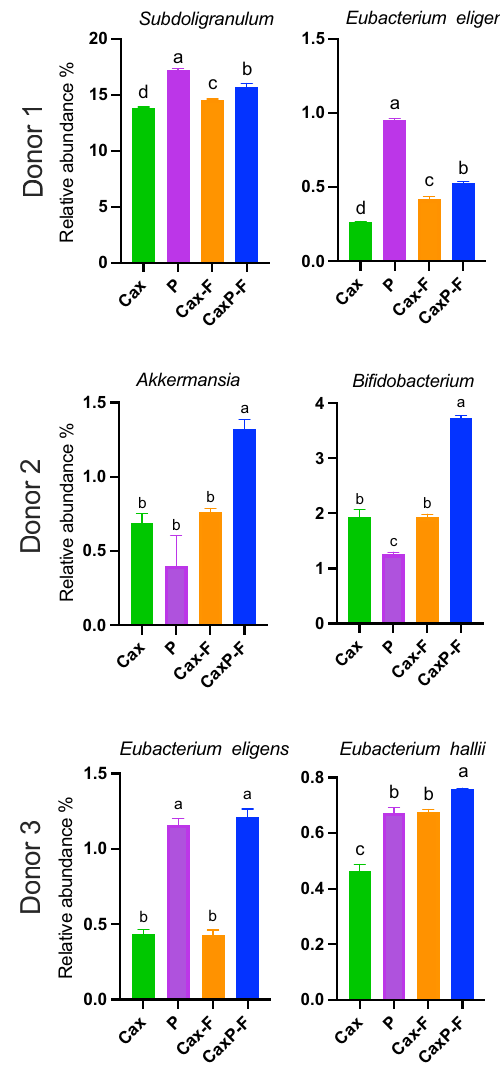
Figure 8. Select bacteria in each donor showing increase in relative abundance (%) in Cax film with embedded pectin. Error bars represent the standard error of the mean of three replicates. Different letters indicate significant differences among the substrates (Tukey’s multiple comparison test, α =